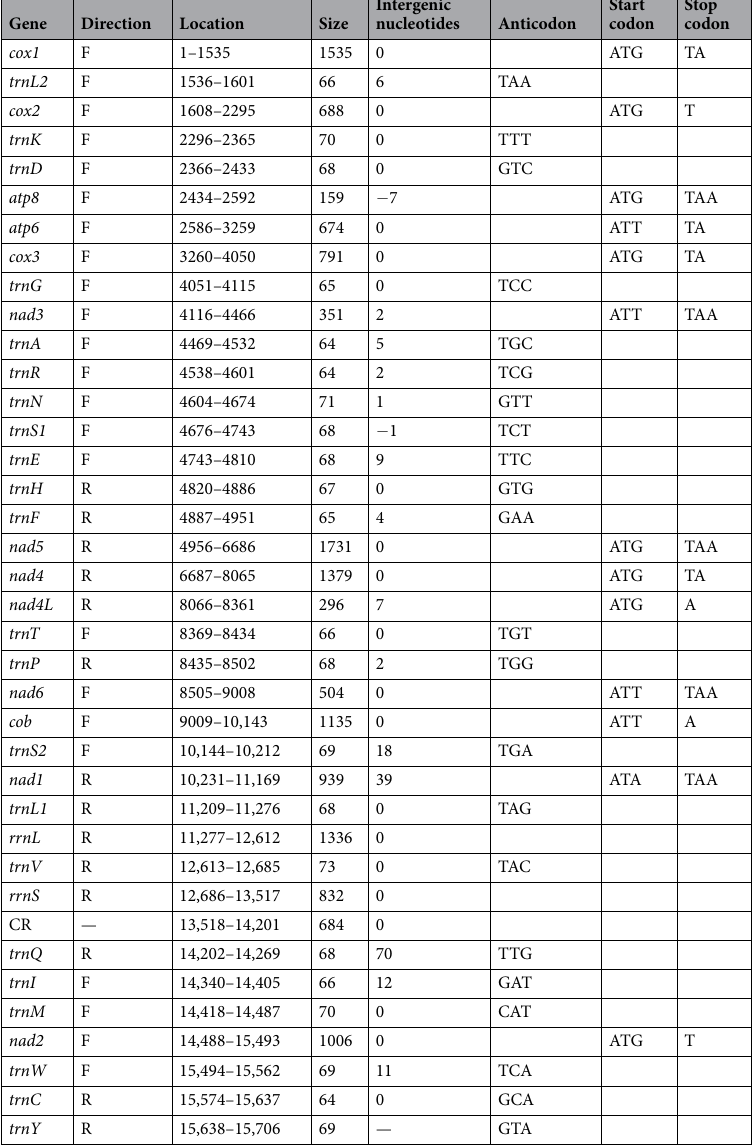
Table 3. Summary of Clistocoeloma sinensis